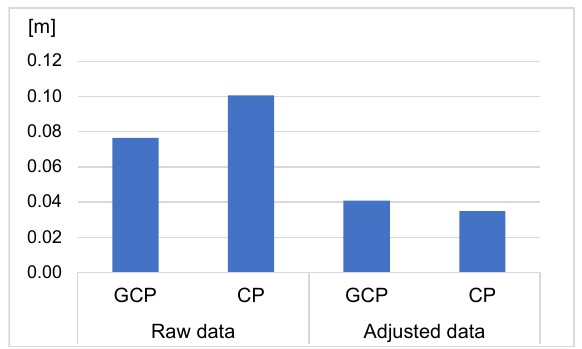
Figure 4. RMSE for ground points